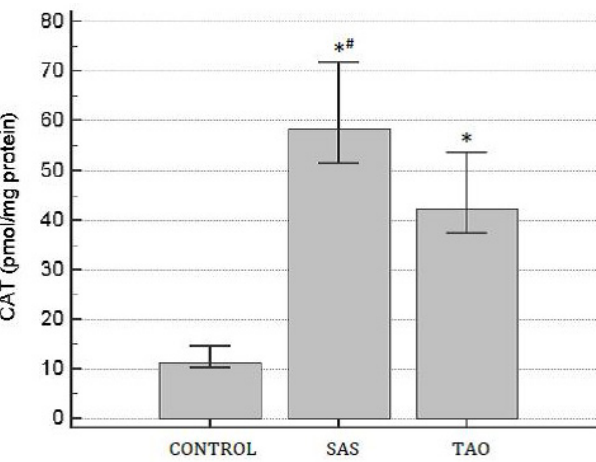
Fig. 4 - Catalase (CAT) activity on human aortas of patients with severe aortoiliac occlusive stenosis (SAS) and with total aortoiliac occlusion (TAO). Values are expressed in mean and the brackets represent interval of confidence of 95%. ANOVA followed test t. *P<0.05 when compared to control group; # P<0.05 when compared to TAO